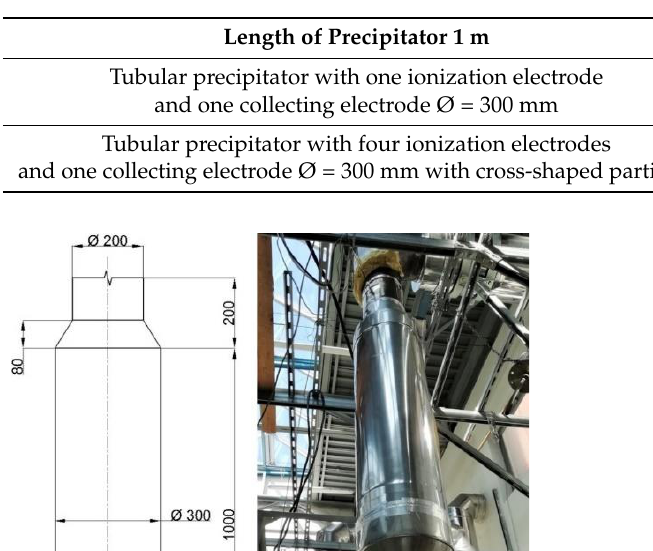
Figure 1. Partition made of two sheets, welded in the shape of a cross. Table 1. Increase in the collection area.